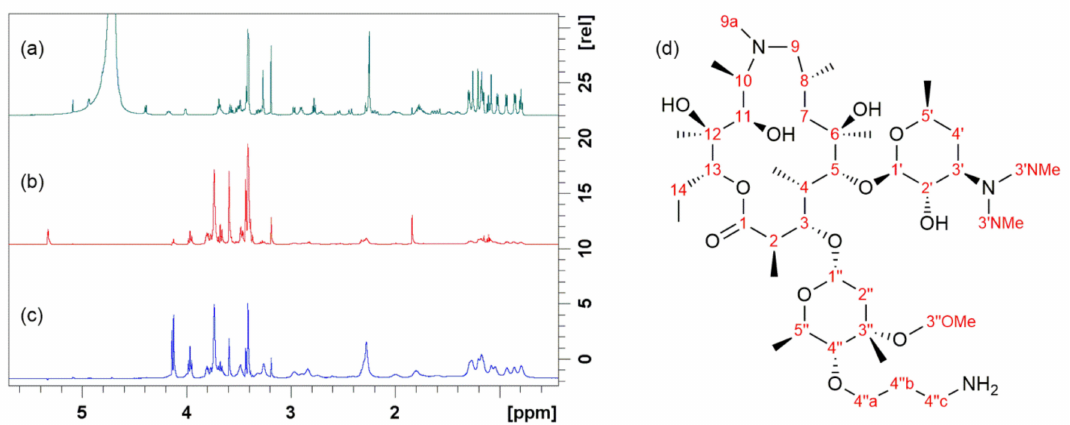
Figure 7. Binding of 4”-aminopropyl azithromycin to the E. coli ribosome studied by STD: ( a ) Proton spectrum prior to the ribosome addition; ( b ) O ff -resonance spectrum after the ribosome addition; ( c ) Di ff erence spectrum after the ribosome addition; ( d ) Chemical structure and atom numbering of 4”-aminopropyl azithromycin. The spectra were recorded at 25 ◦ C and 600 MHz in Tris-d 11 bu ff er (pH